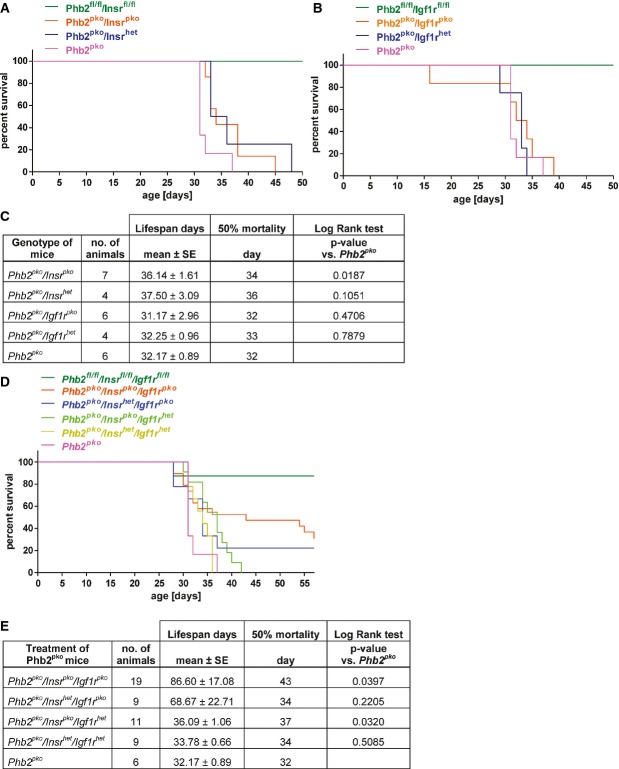
Podocyte-specific knockout of the insulin receptor and IGF-1 receptor prolongs survival of Phb2pko mice
A Kaplan–Meier survival curve showed that an additional knockout of the insulin receptor (Insr) prolonged survival of Phb2pko mice (n = 7 for Phb2pko/Insrpko, n = 4 for Phb2pko/Insrhet, and n = 6 for Phb2pko).B Kaplan–Meier survival curve revealed that the survival time of Phb2pko mice is not changed by an additional Igf1r deficiency (n = 6 for Phb2pko/Igf1rpko, n = 4 for Phb2pko/Igf1rhet, and n = 6 for Phb2pko).C Statistical analysis comparing all genotypes with Phb2pko mice.D Kaplan–Meier survival curve revealed prolonged survival of Phb2pko/Insrpko/Igf1rpko and Phb2pko/Insrpko/Igf1rhet mice (n = 19 for Phb2pko/Insrpko/Igf1rpko, n = 9 for Phb2pko/Insrhet/Igf1rpko, n = 11 for Phb2pko/Insrpko/Igf1rhet, n = 9 for Phb2pko/Insrhet/Igf1rhet, and n = 6 for Phb2pko).E Statistical analysis comparing all genotypes with Phb2pko mice.